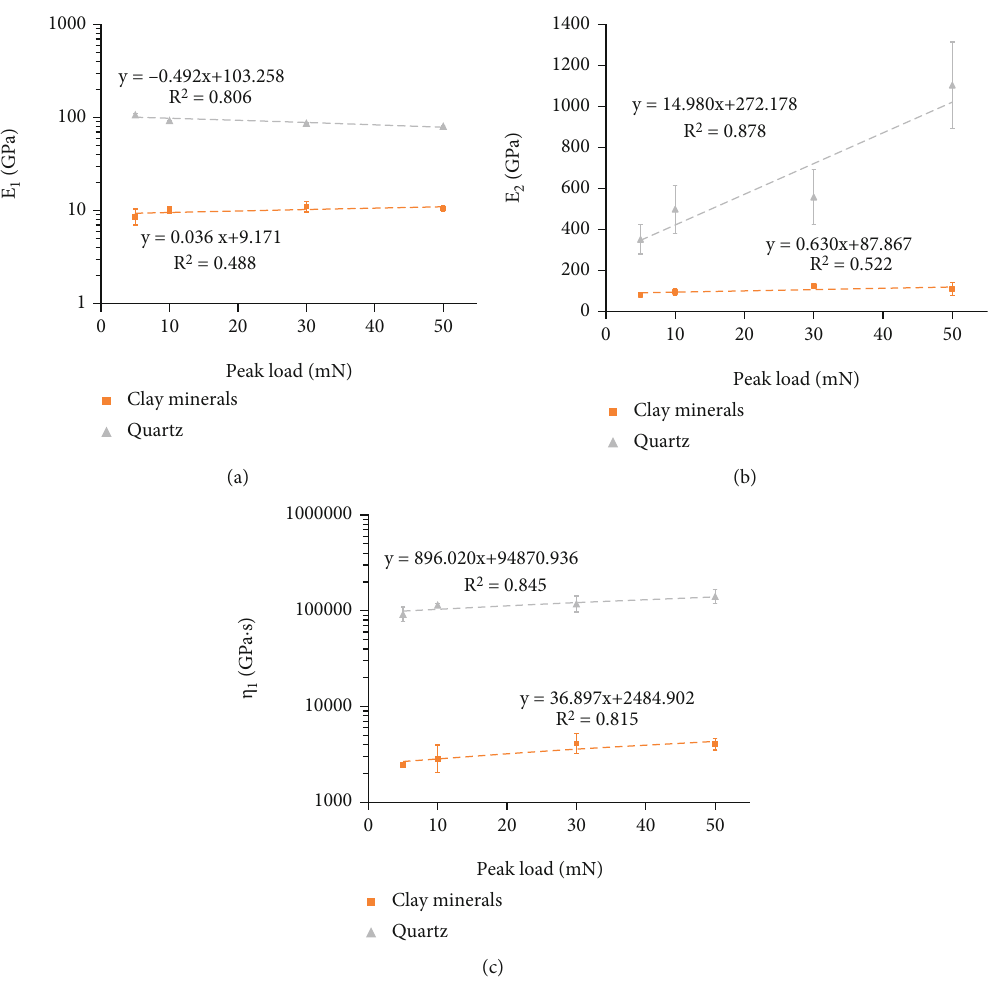
Figure 8: Linear regressions for employing the three-element Voigt model for quartz and clay minerals at various peak loads. Fitting parameters: (a) E , (b) E , and (c) η . Error bars are one standard deviation. 1 2 1 Table 2: Fitting parameters obtained by di ff erent viscoelastic models of typical creep curves at 30 mN. Model Three element Voigt Burgers Two dashpot kelvin